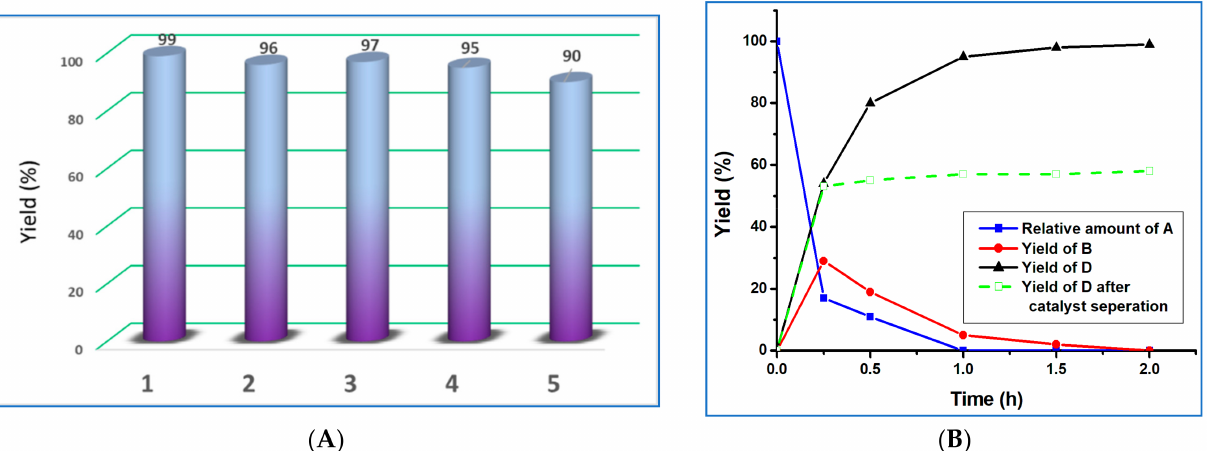
Figure 3. ( A ) Yields of 2-benzylidenemalononitrile by using CPs 1 – 5 as catalysts. ( B ) Yield vs. time plot for the deacetalization–Knoevenagel condensation reactions catalyzed by CP 1 (black line: yield of 2-benzylidenemalononitrile ( D ); red line: yield of benzaldehyde ( B ); blue line: percentage of unreacted benzaldehyde dimethyl acetal ( A ); dotted green line: yield of 2-benzylidenemalononitrile ( D ) upon separating the catalyst after 0.25 h of reaction